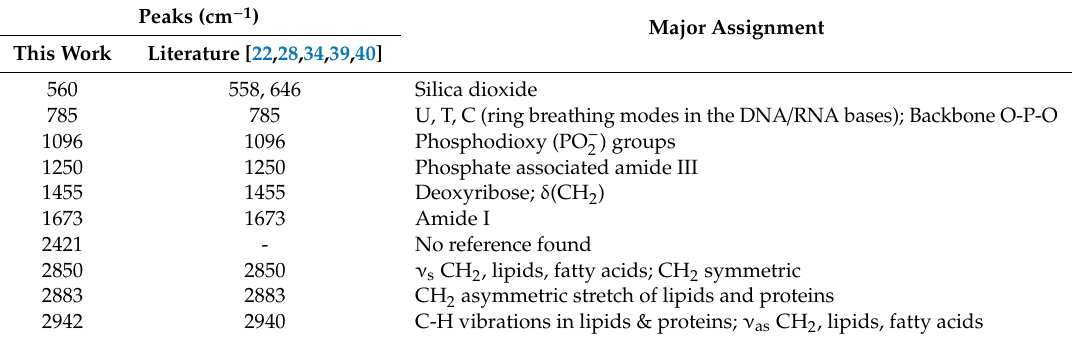
Table 6. Peak position and mode assignment of demineralized areas of benign mixed tumor (sample